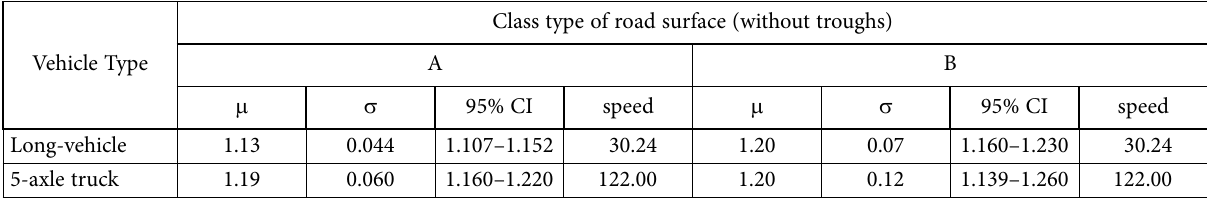
Table 3. Mean value ( µ ) and standard deviation ( σ ) of DAF for road classes A and B (critical speed in km/h)